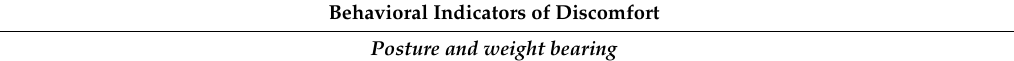
Table A1. Discomfort Behaviors Observed Among 20 Orthopedic Surgical Equine Patients. Table 1. Discomfort Behaviors Observed Among 20 Orthopedic Surgical Equine Patients. Table 1. Discomfort Behaviors Observed Among 20 Orthopedic Surgical Equine Patients. Table 1. Discomfort Behaviors Observed Among 20 Orthopedic Surgical Equine Patients. Table 1. Discomfort Behaviors Observed Among 20 Orthopedic Surgical Equine Patients. Table 1. Discomfort Behaviors Observed Among 20 Orthopedic Surgical Equine Patients. Table 1. Discomfort Behaviors Observed Among 20 Orthopedic Surgical Equine Patients. Table 1. Discomfort Behaviors Observed Among 20 Orthopedic Surgical Equine Patients. Table 1. Discomfort Behaviors Observed Among 20 Orthopedic Surgical Equine Patients. Behavioral Indicators of